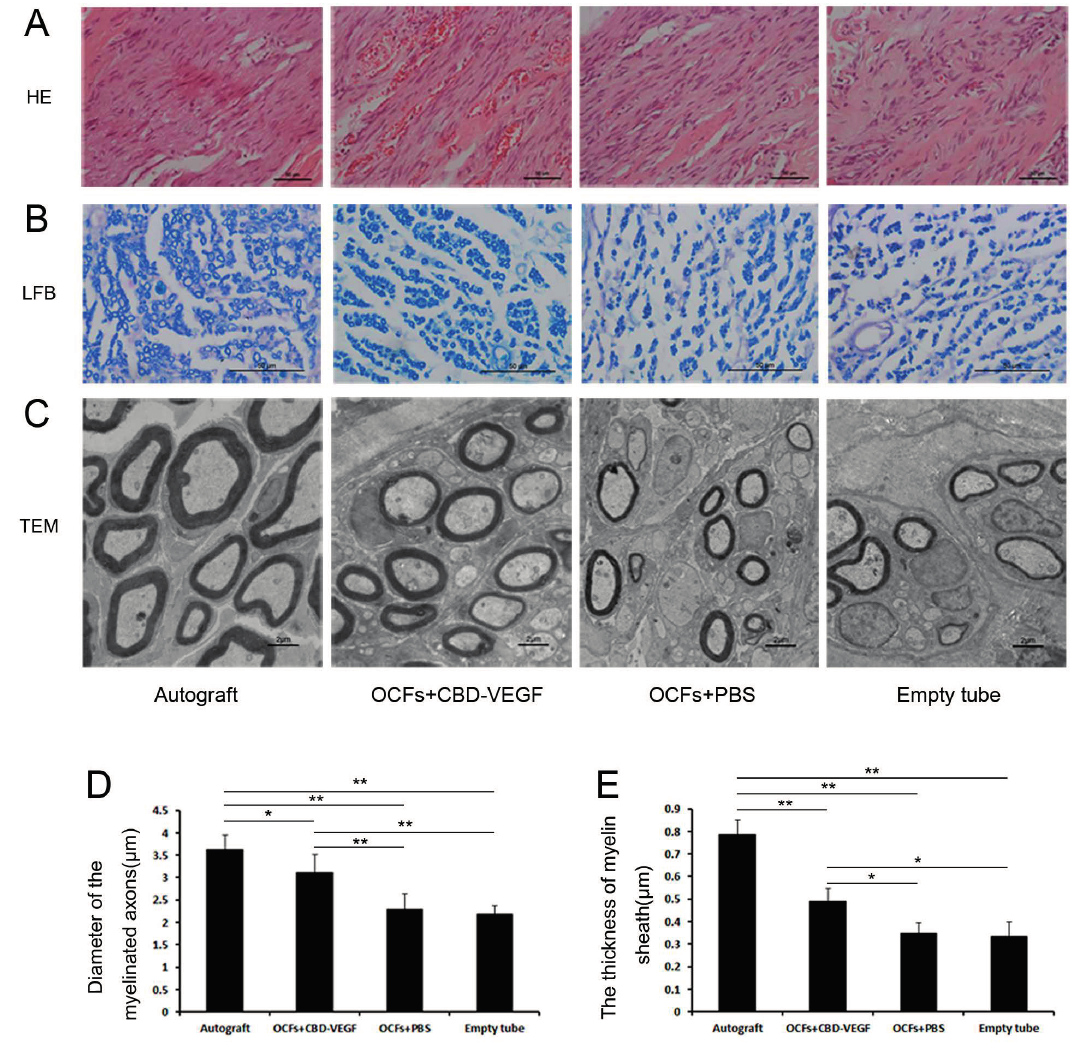
( n = 4, p < 0.05), indicating better recovery from muscle atrophy (Figure 8). There was no significant difference in the muscle area between the OCFs + CBD-VEGF and autograft groups ( n = 4, p > 0.05). Figure 7. Histological analysis of regenerated nerve at week 12 after injury. ( A ) HE staining of longitudinal sections in the four groups. Scale bar, 50 µm; ( B ) Light micrographs of transverse sections from each group, stained with luxol fast blue (LFB). Scale bar, 50 µm; ( C ) Transmission electron microscopy (TEM) images of ultrathin sections in each group. Scale bar, 2 µm; ( D ) Statistical analysis of the diameter of myelinated axons, n = 5; ( E ) Statistical analysis of myelin sheath thickness, n = 3. Data are expressed as mean ± SD, * p < 0.05, ** p <